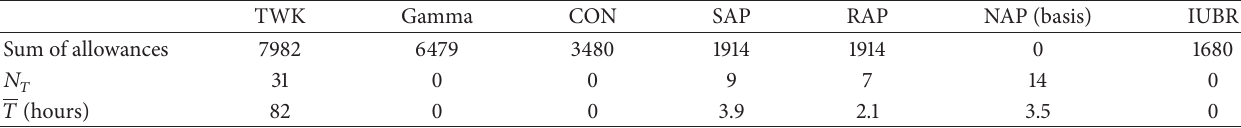
Table 10: The performances of various allowance determination